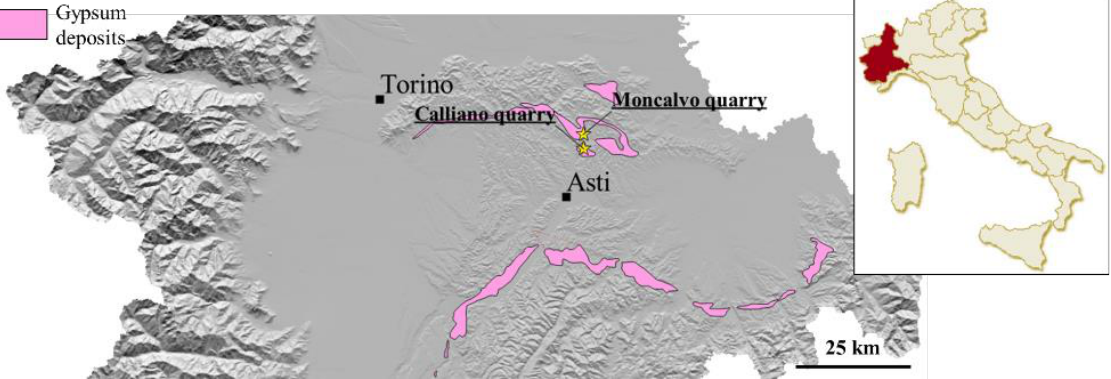
Figure 1. Areal distribution of Messinian gypsum deposits in Piedmont and geographical location of the test sites.